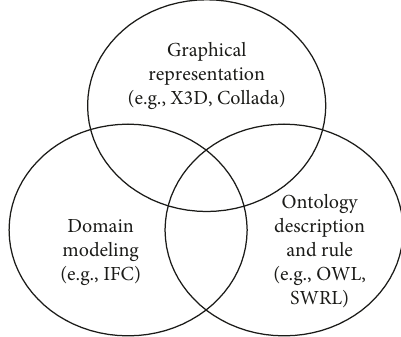
Figure 8: Integration of the XML